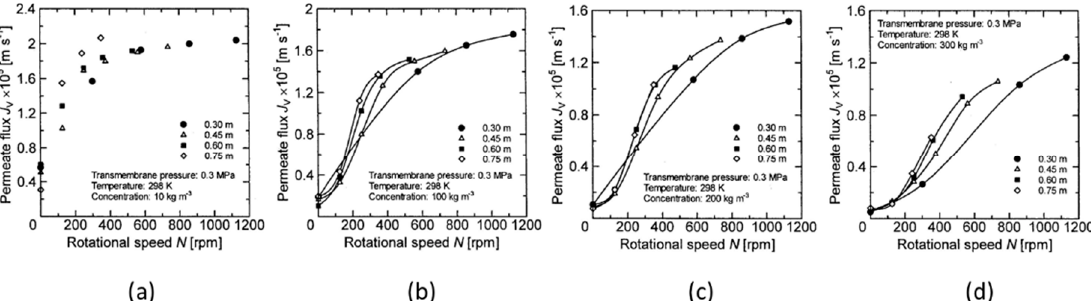
Figure 11. Relationship between rotation speed and permeate flux when the TMP is 0.3 Mpa. (( a ) at latex concentration 10 kg/m 3 ( b ) 100 kg/m 3 ( c ) 200 kg/m 3 ( d ) 300 kg/m 3 .